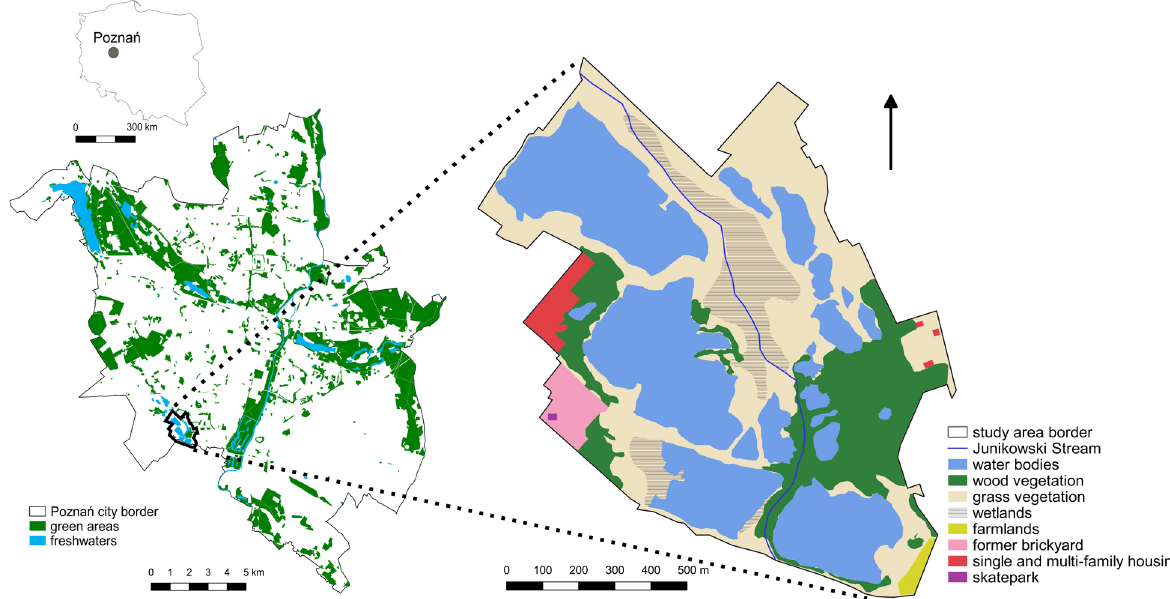
Fig. 1. Study area (according to Urban Atlas